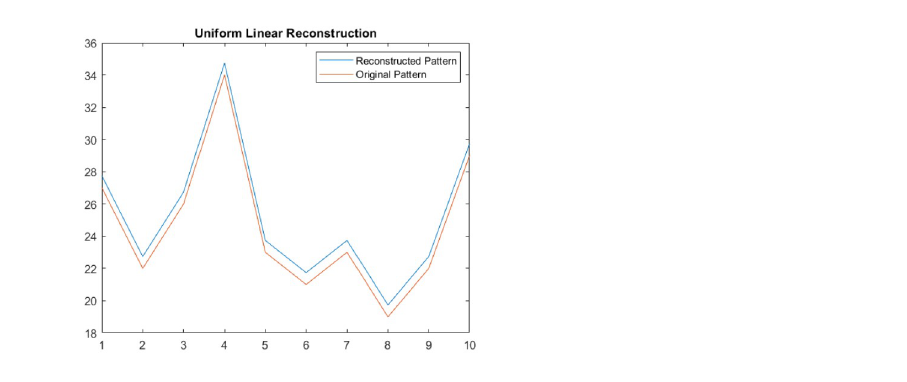
Fig 12. Plotting original and reconstructed curves in a uniform privacy distribution.